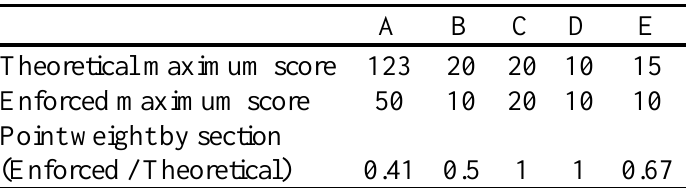
Table A2.1. Determining weights for each section in Board of Water and Soil Resources Wetland Restoration scoring system.